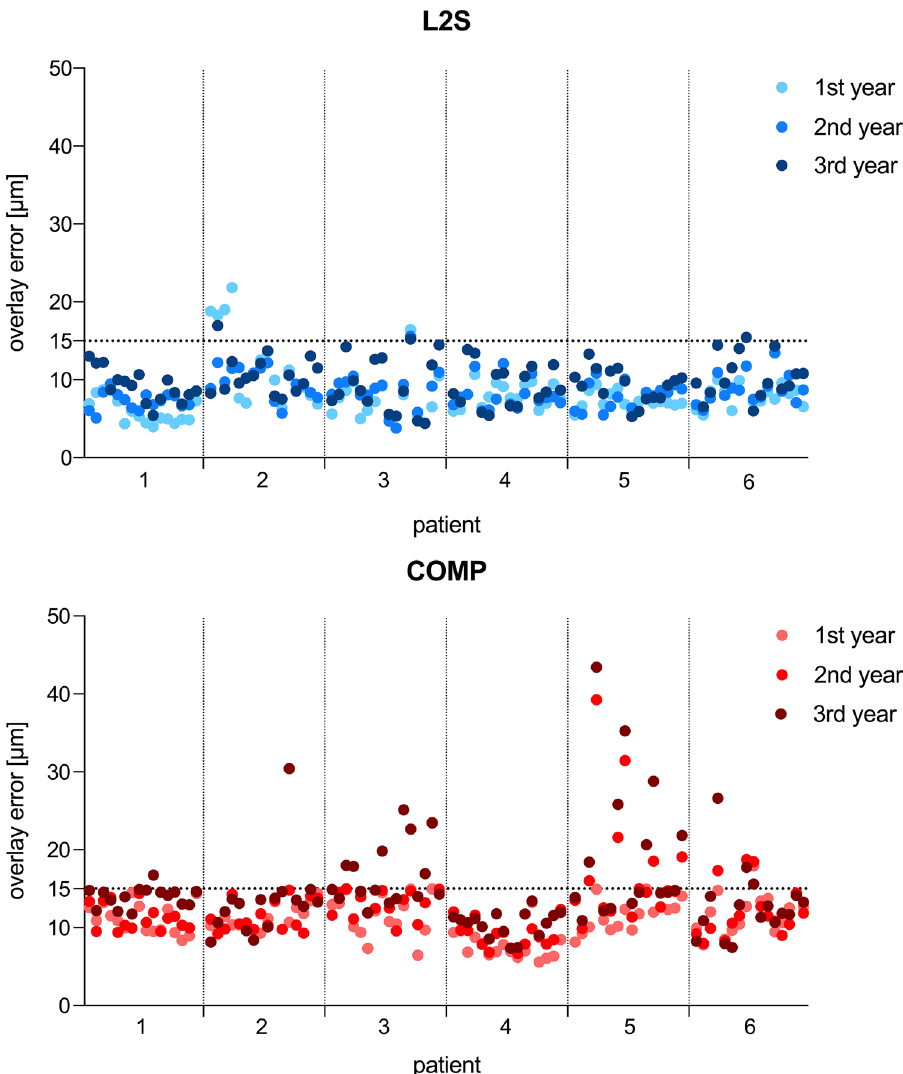
Figure 2. Visualized superimposition error (µm) of each specimen and individual patient. Superimposition error under 15 µm was defined as the requirement for further data